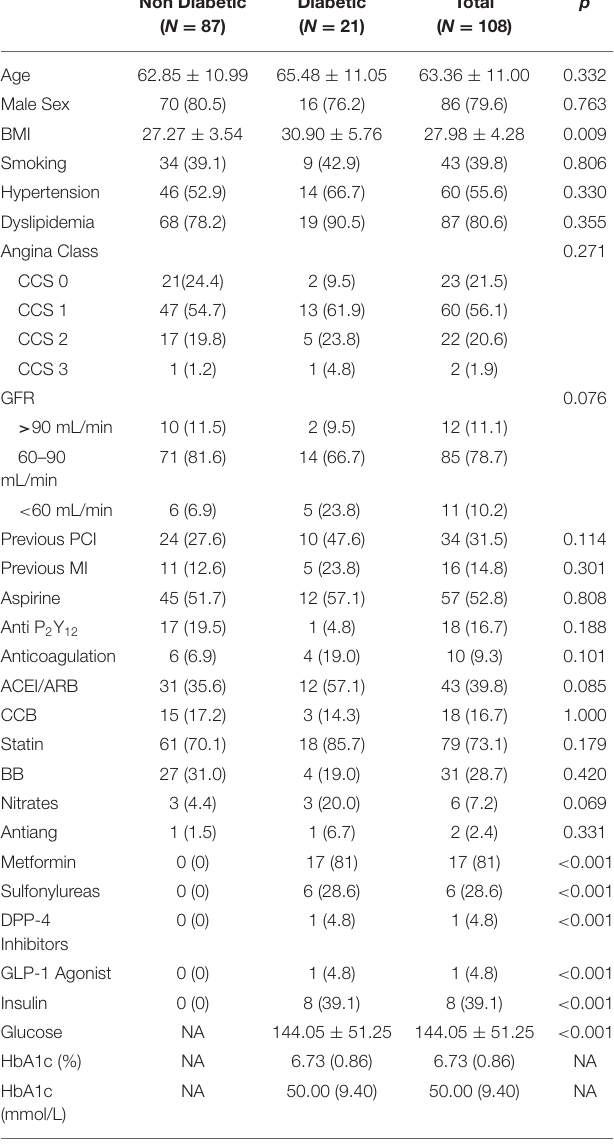
TABLE 1 | Patients